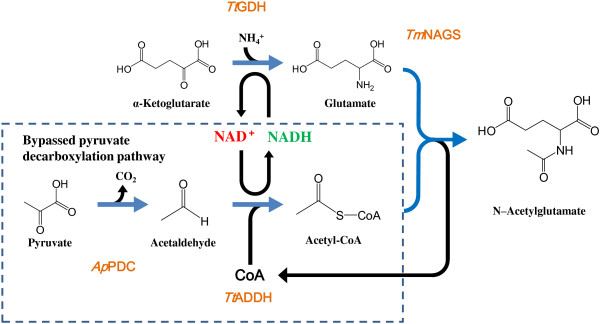
Schematic illustration of the designed pathway for NAG production. Abbreviations used: ApPDC, pyruvate decarboxylase from Acetobacter pasteurianus; TtADDH, CoA-acylating aldehyde dehydrogenase from Thermus thermophilus; TtGDH, glutamate dehydrogenase from Thermus thermophilus; TmNAGS, N-acetylglutamate synthase from Thermotoga maritima.